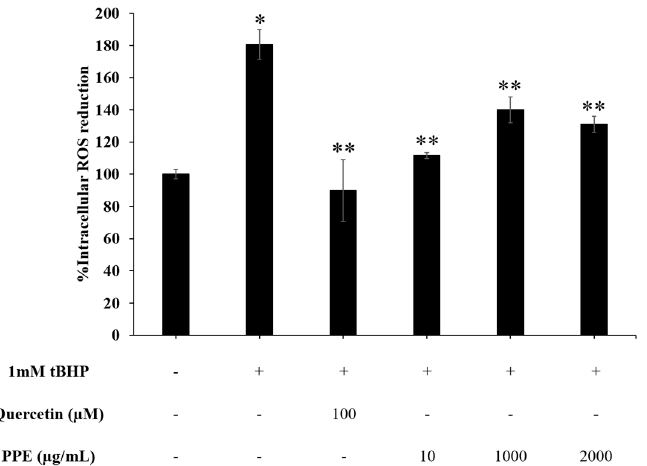
Figure 6. Effect of 100 µM quercetin and various concentrations of PPE (10–2000 µg/mL) on intra- cellular ROS reduction in HaCaT after induction of ROS production by 1 mM tBHP for 1 h. The DMEM-treated group was used as a negative control, and the t-BHP-treated group was used as a positive control. * and ** signify a significant difference ( p < 0.05) when compared to the DMEM-treated group and the t-BHP-treated group, respectively.